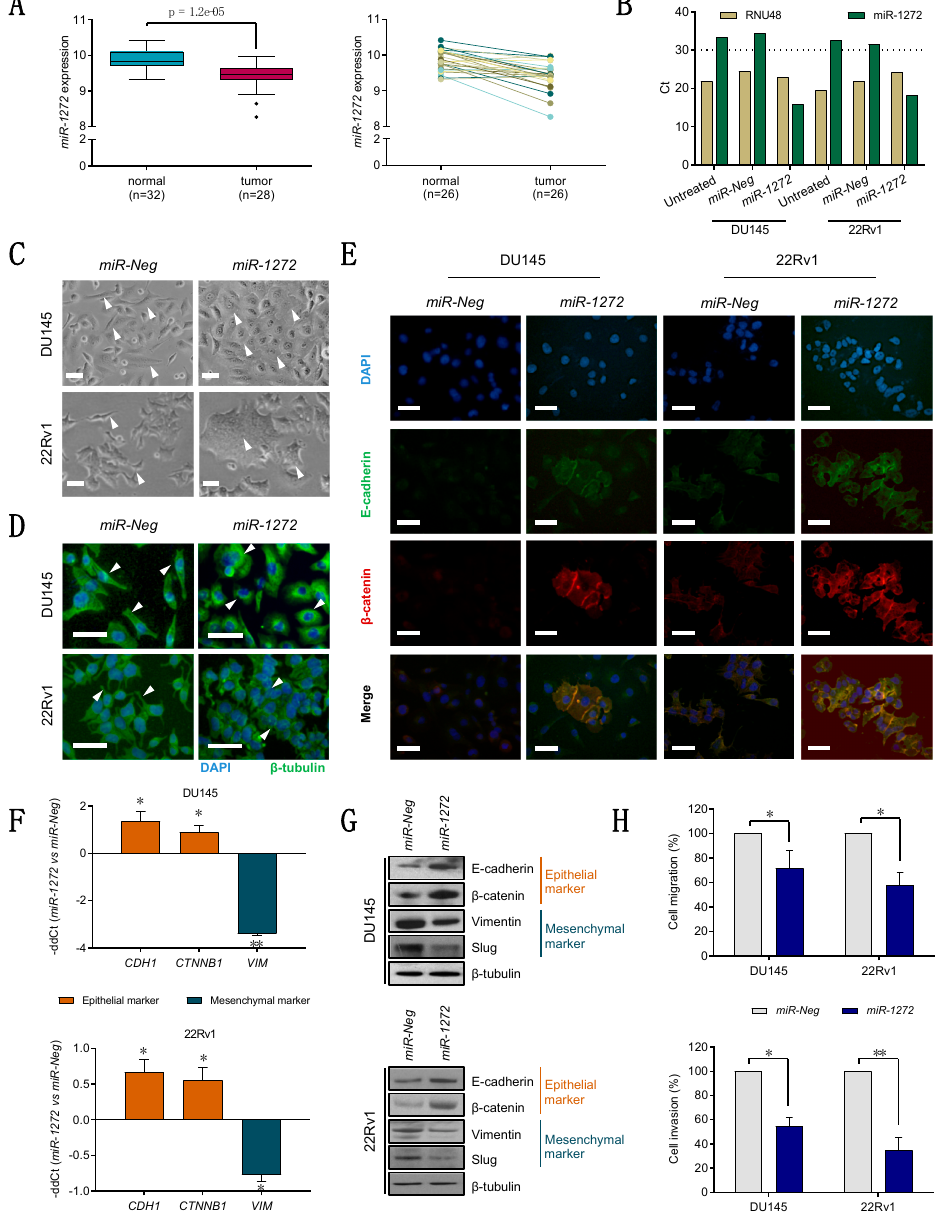
Figure 1. miR-1272 reverts the mesenchymal phenotype and affects migratory and invasive properties of PCa cells. ( A ) miR-1272 expression in prostate normal and tumor tissue specimens, as from microarray analysis (left). miR-1272 expression in matched normal/tumor pairs is reported (right). ( B ) Representative RT-qPCR showing the expression levels of endogenous control RNU48 (beige columns) and miR-1272 (green columns) in untreated, miR-Neg and miR-1272 transfected DU145 and 22Rv1 cell lines. Expression values are reported as Cycle threshold (Ct). ( C ) Representative bright- field microphotographs showing morphological changes occurring in miR-1272 transfected DU145 and 22Rv1 cell lines as compared to miR-Neg cells. Scale bar, 50 μ m. ( D ) Representative immunofluorescence microphotographs showing the organization of β -tubulin cytoskeleton in miR- 1272 transfected DU145 and 22Rv1 cell lines as compared to miR-Neg cells. Scale bar, 50 μ m. ( E )